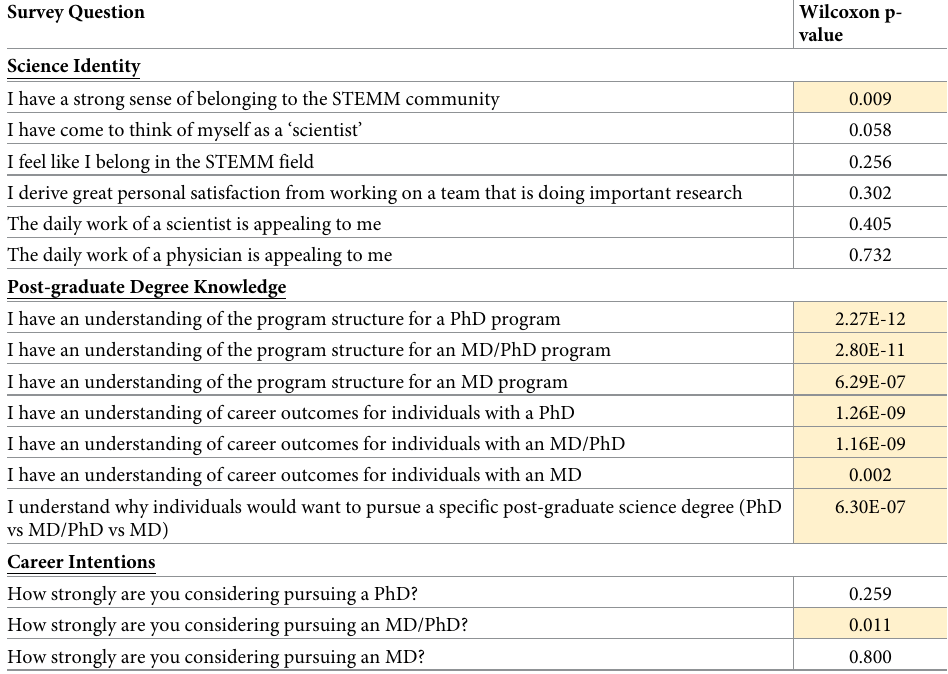
highlighted in yellow. See Fig 2, S2 Fig, Fig 3, and S4 Fig for individual response changes.